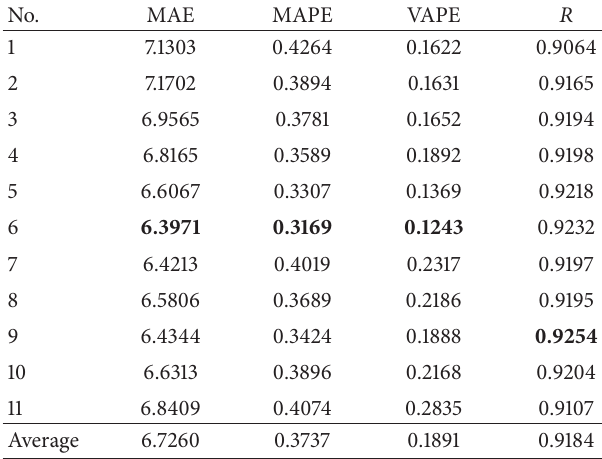
Table 2: Comparison of performance among WNNMs with differ- ent number of hidden